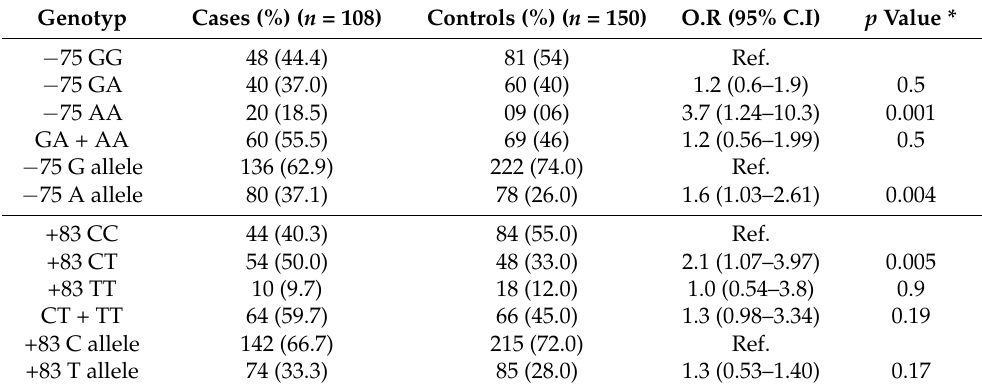
Table 1. Distribution of various combinations of genotypes in APOA1 − 75 G>A and 83 C>T (bladder cancer cases and healthy